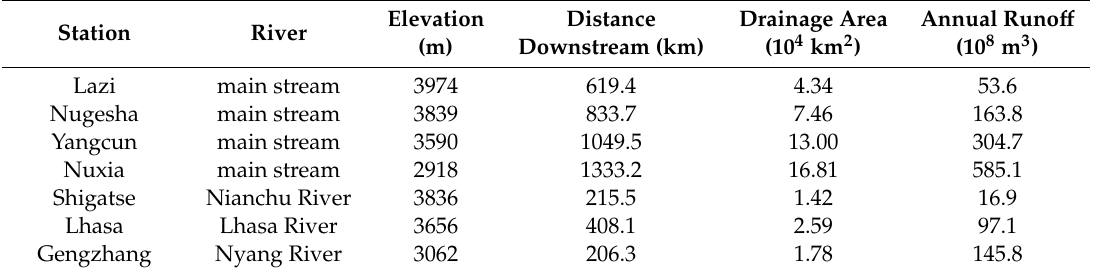
Table 1. Hydrological settings of the Yarlung Tsangpo River Basin.